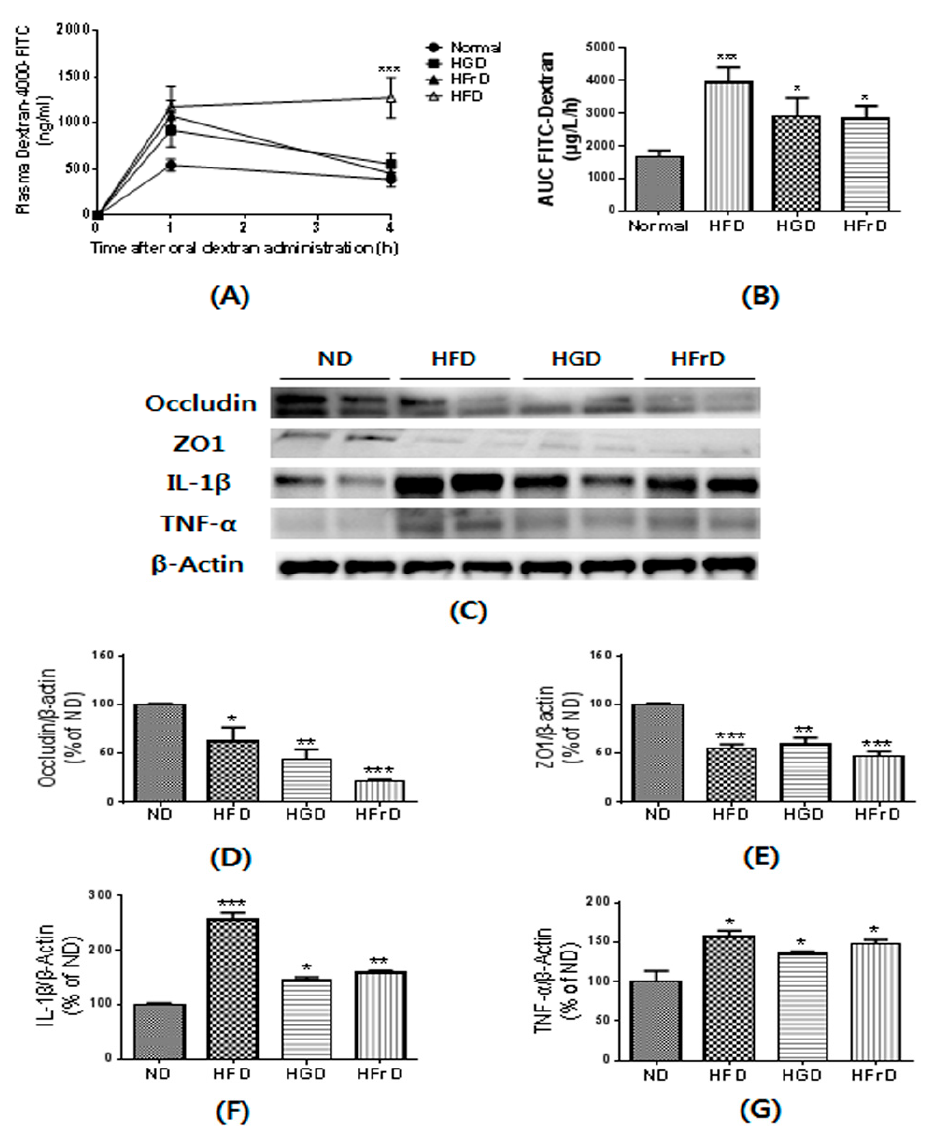
Figure 4. HFD, HGD or HFrD-induced changes of gut permeability and related proteins expression. ( A ) plasma fluorescein isothiocyanate (FITC)-dextran concentration; ( B ) AUC of Plasma FITC-dextran levels; ( C ) representative images of Western blots for tight junction proteins (Occludin and ZO1) and inflammatory cytokines (IL-1 β and TNF- α ); ( D – G ) relative band intensities of Occludin ( D ), ZO1 ( E ), IL-1 β ( F ) and TNF- α ( G ) normalized to those of β -actin. Data are presented as mean ± SEM for 9 mice per group ( A , B ) and mean percentage of ND ± SEM of three independent experiments (C-G) (* p < 0.05, ** p < 0.01, and *** p < 0.001 vs.